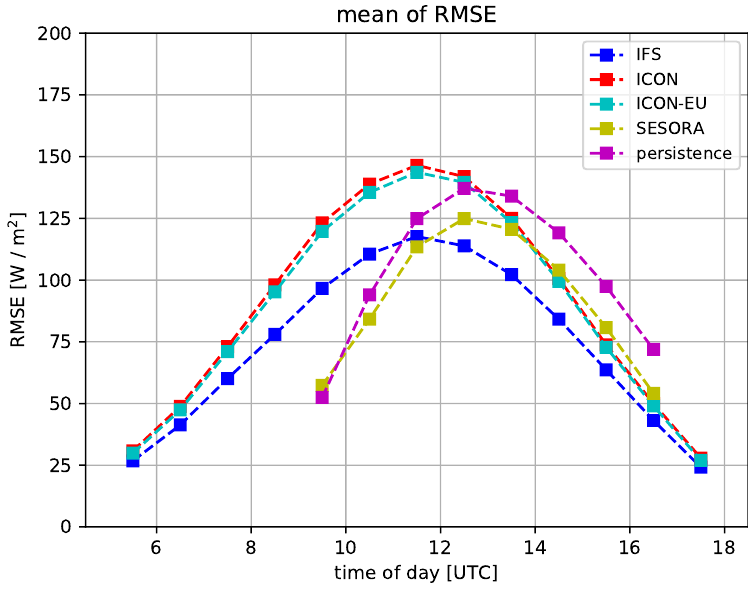
Figure 9. Plot of the mean of RMSE of SIS for 13 cases against the time of day. The comparison is shown for IFS (Integrated Forecasting System) by the ECMWF (European Centre for Medium-Range Weather Forecasts), ICON (ICOsahedral Nonhydrostatic) and ICON-EU (ICON only for Europe) by the German Weather Service (DWD), SESORA and persistence. The validation was performed with SARAH-2 data by the CM SAF. For SESORA and persistence the forecast was initiated at 09:15 UTC. They have a maximum lead time of 8 h. IFS is available every 12 h, ICON/ICON-EU every 3 h. It was taken from the model run, which would be available in reality, thus initiation time plus the time for the model run to finish (IFS takes 6 h; ICON/ICON-EU takes 3 h). Image adapted from